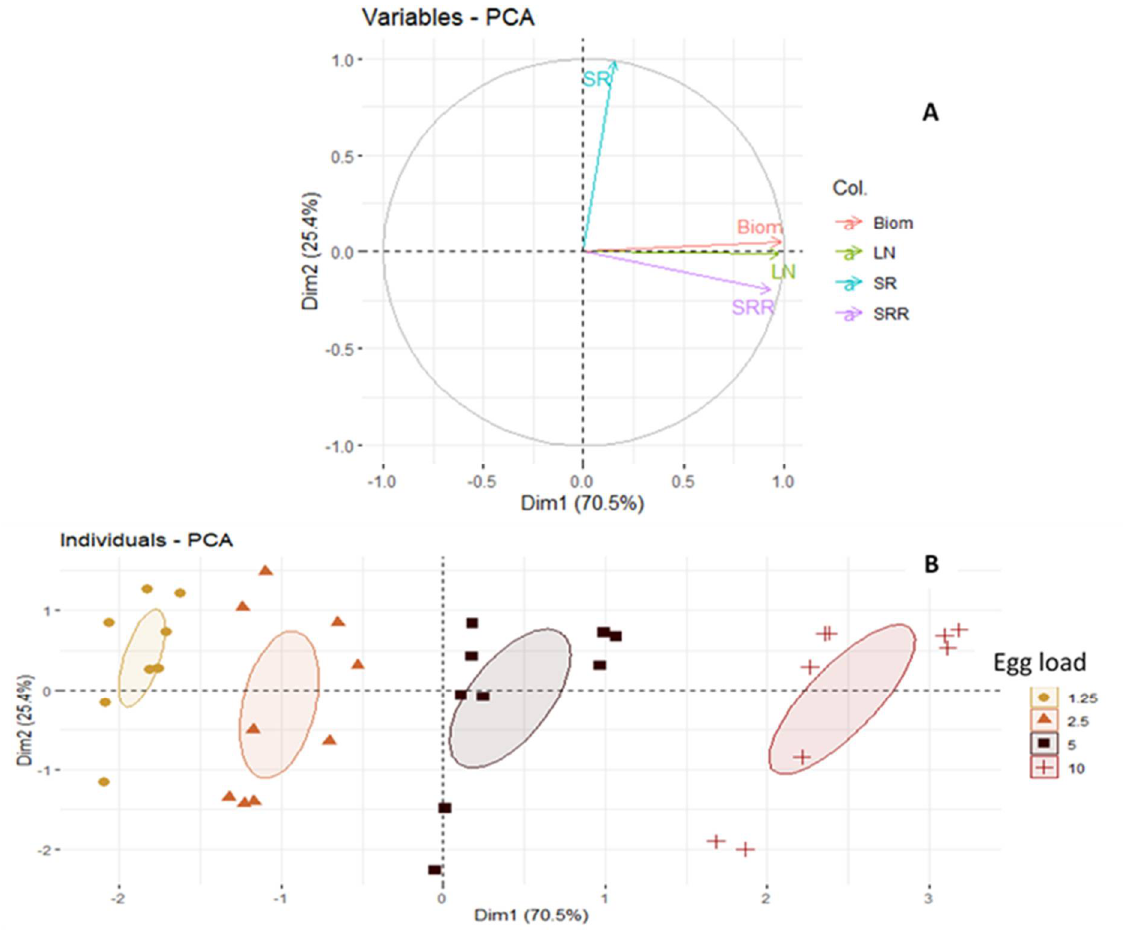
Figure 1. ( A ) Circle of correlation of variables. ( B ) Graphical representation of individuals as a Figure. Biom: biomass; LN: larval number; SR: survival rate; SRR: substrate reduction rate.